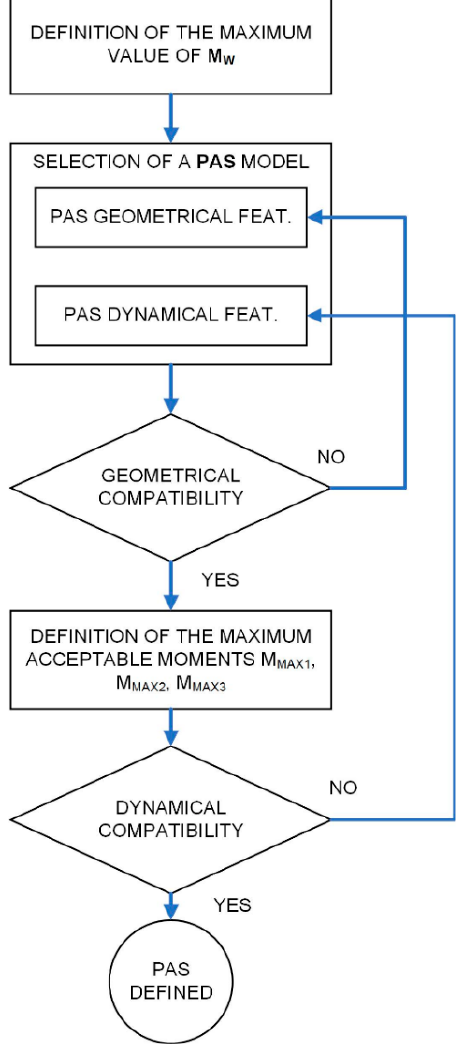
Figure 8. Scheme of the PAS selection procedure.